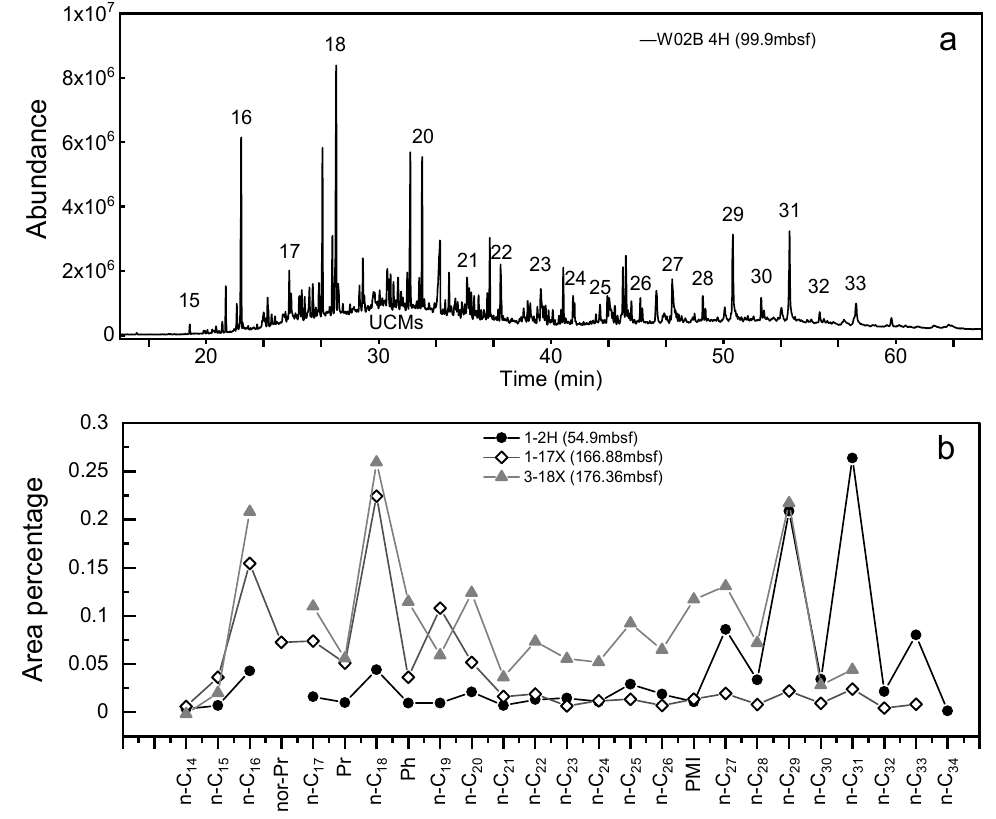
Figure 4. ( a ) Total ion chromatogram (TIC) of extracts from the studied sample W02B-4H (99.9 mbsf); ( b ) representative n -alkane composition from W01B-2H (54.9 mbsf), W01B-17X (166.88 mbsf), and W03B-18X (176.36 mbsf).